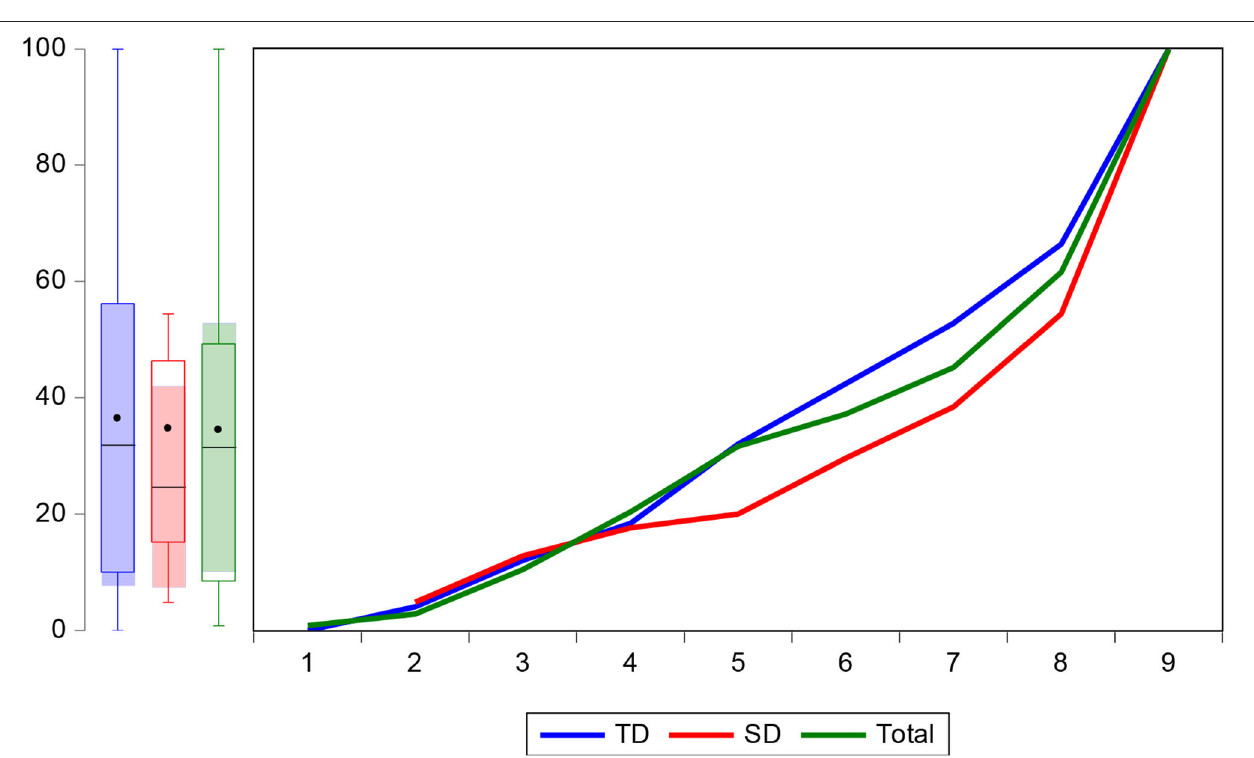
FIGURE 3 | Cumulative distribution of the efficiency scores for TD and DP